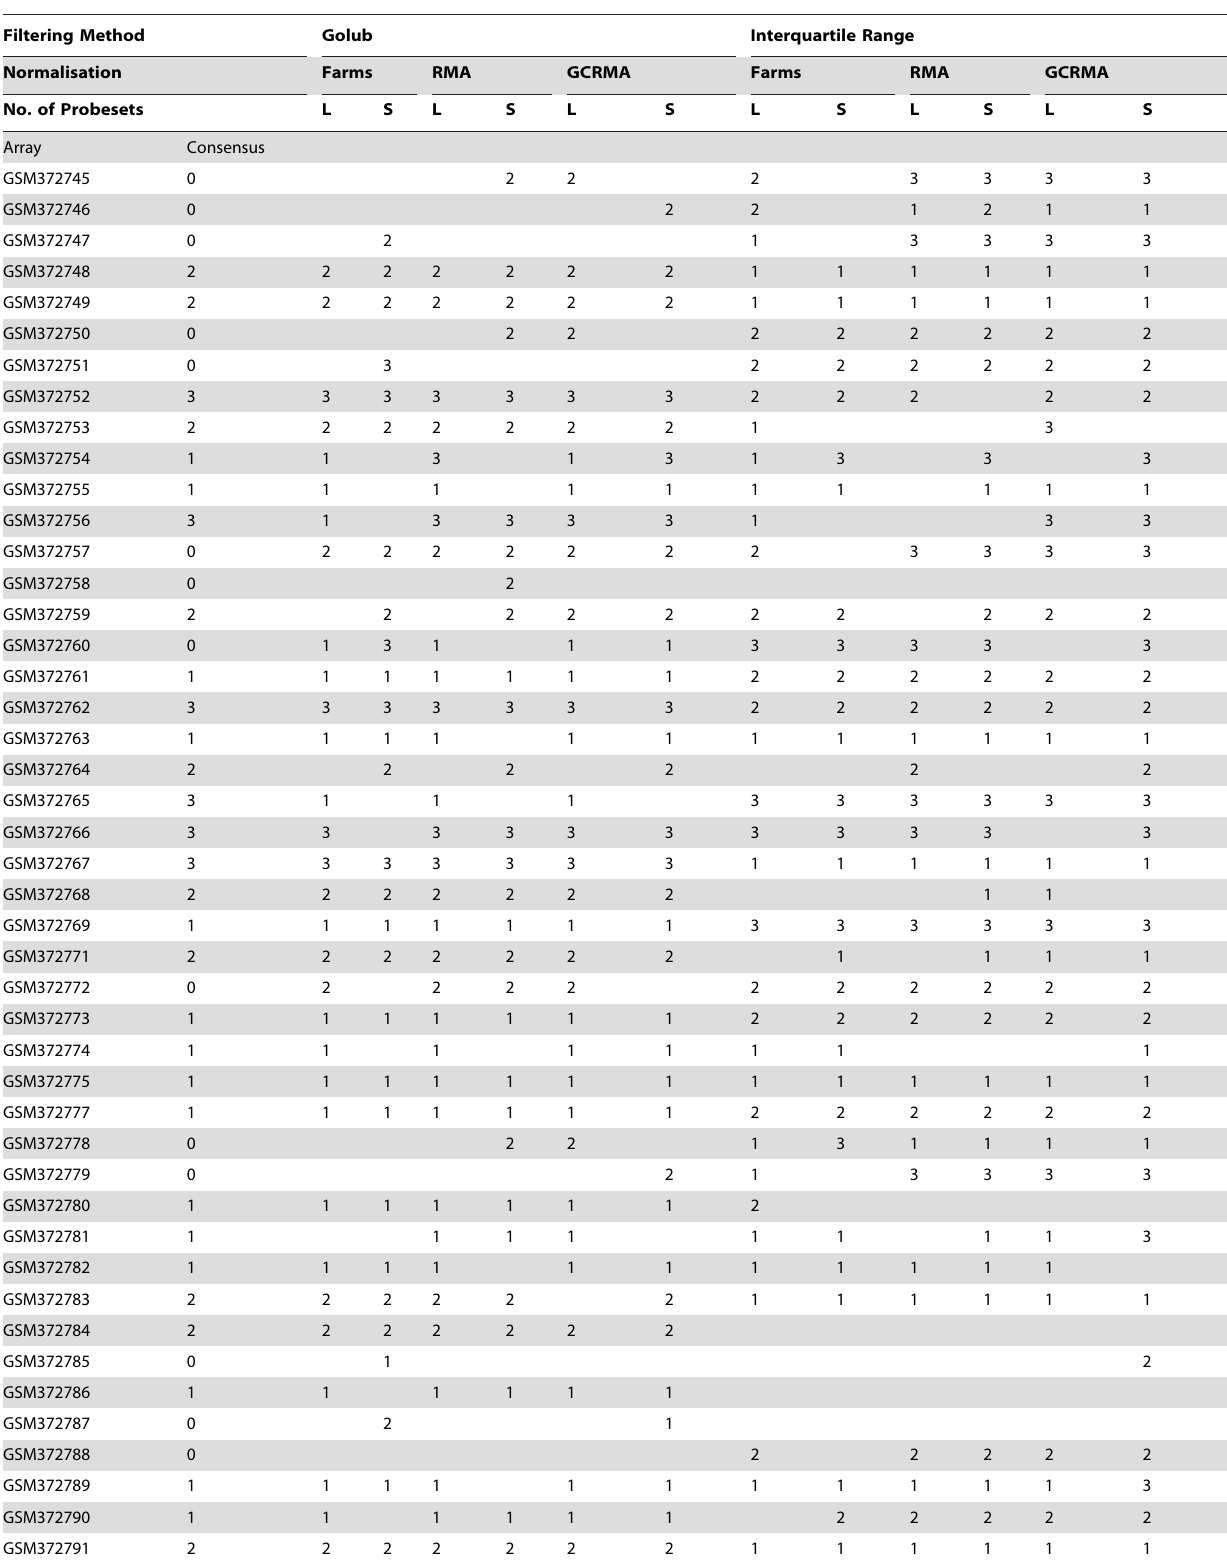
Table 2. Cluster Assignments and the Consensus From Analysis of the Dendrograms Produced by Agglomerative Hierarchical Clustersing of the Normalised and Filtered